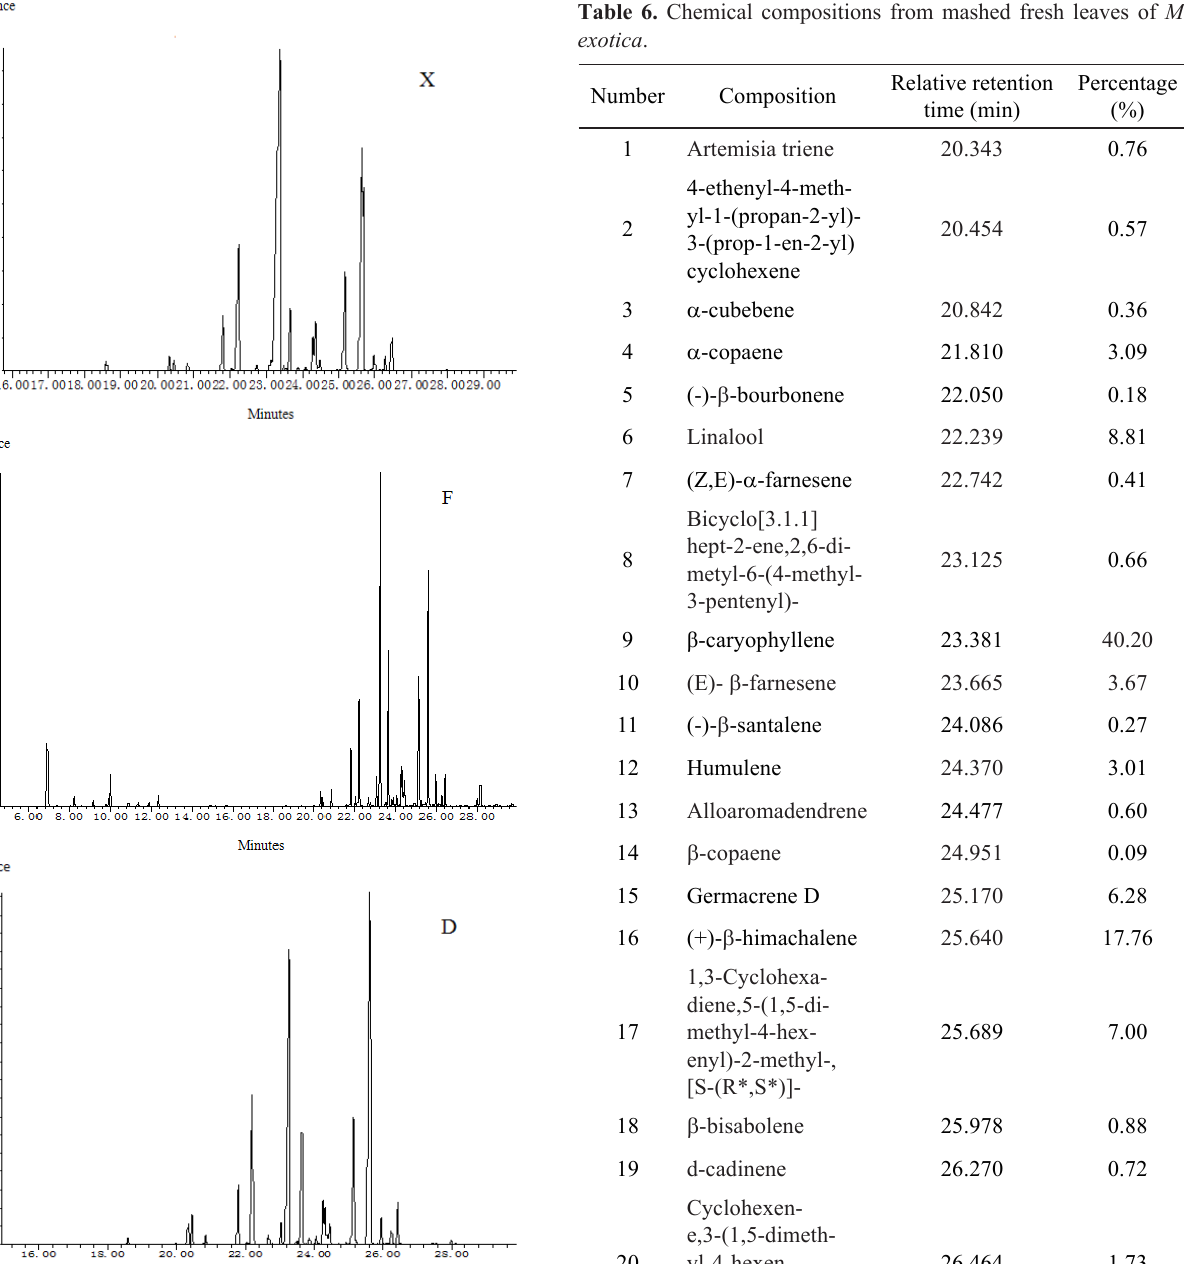
Table 6. Chemical compositions from mashed fresh leaves of